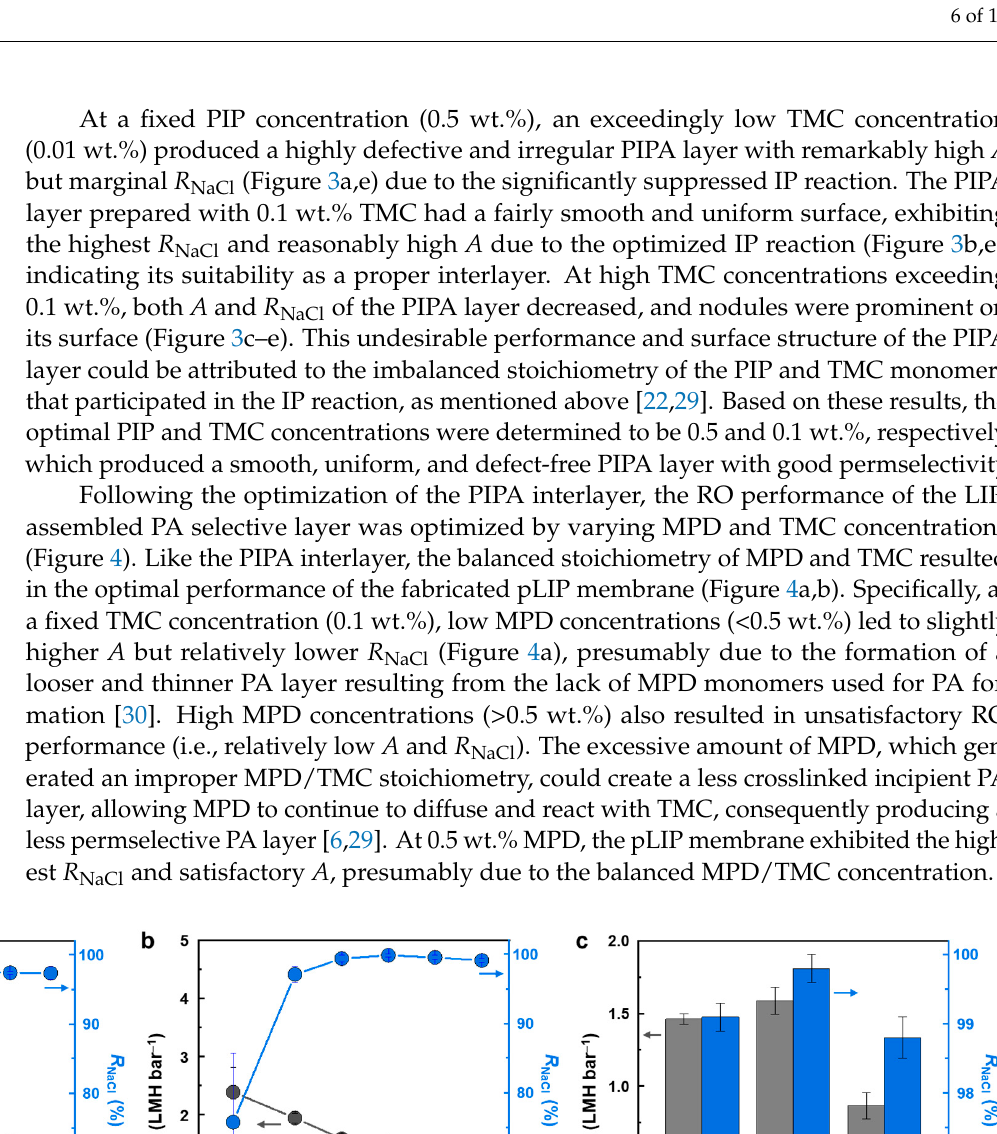
Figure 4. Performance optimization and comparison of the PIPA-interlayered LIP (pLIP) mem- branes. ( a , b ) Water permeance ( A ) and NaCl rejection ( R NaCl ) of the pLIP membranes prepared with ( a ) different MPD concentrations at 0.1 wt.% TMC and ( b ) different TMC concentrations at 0.5 wt.% MPD. ( c ) The RO performance of the optimized LIP, pLIP, and conventional IP membranes.